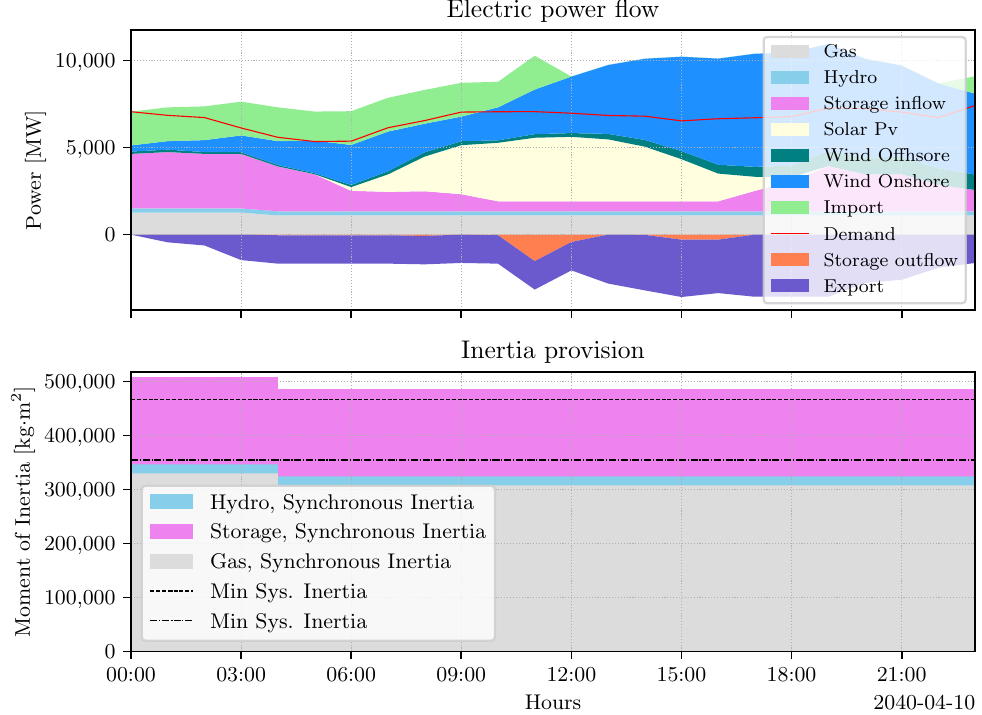
Figure 3. Illustration of a 24 h time series of the base scenario. The top subplot depicts electric power flow results and the bottom subplot flow provided